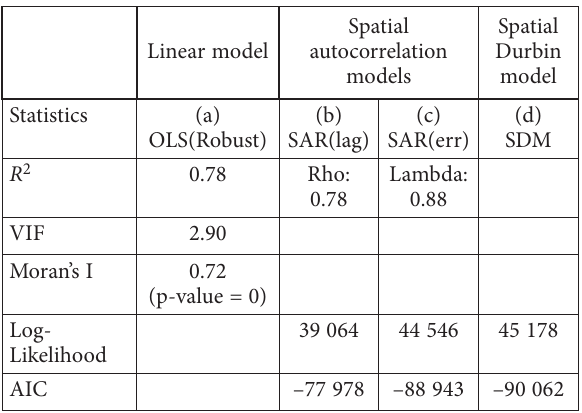
Figure 1. Examples of the orientation dummy variables (Source: Lianjia) Table 3. Overall diagnosis statistics of the four econometric models